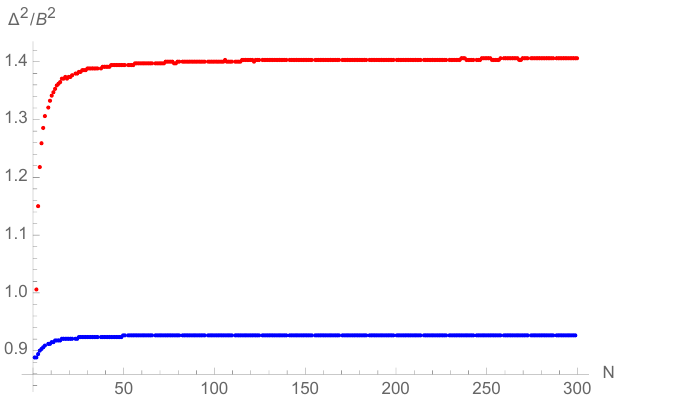
Figure 4 . Test of the Weak Gravity Conjecture for U(1) A . Red: 9 C T / 40 C V,A , Blue: ∆ 2 /q 2 for the lightest meson.